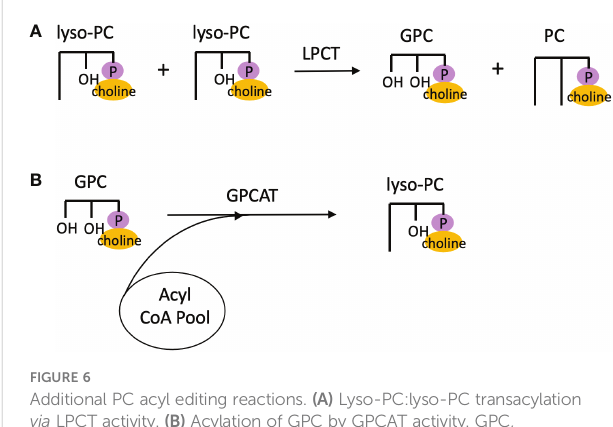
FIGURE 6 Additional PC acyl editing reactions. (A) Lyso-PC:lyso-PC transacylation via LPCT activity. (B) Acylation of GPC by GPCAT activity. GPC, glycerophosphocholine; GPCAT, acyl-CoA:glycerophosphocholine acyltransferase; LPCT, lysphosphatidylcholine transacylase; PC,